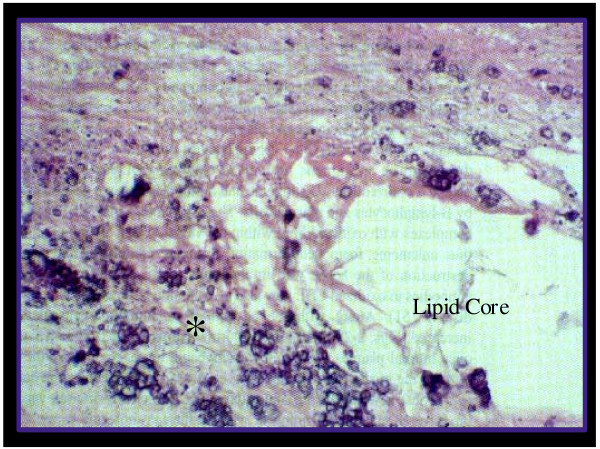
Matrix vesicle formation at the base of the lipid core. This image depicts the formation of matrix vesicles at the base of the lipid core in an atherosclerotic plaque. These vesicles are generated through the wound healing process and act as a nidus for later plaque ossification. A 32 year-old male smoker killed in a motorcycle accident. Left anterior descending coronary artery. Note the basophilic staining at the base of the lipid core (starred) and surrounding areas. This area represents early changes of atheromatous ossification. Coronary artery calcification may not be detected until later in life, however this image portrays VOC as being an active directed process beginning early in life.